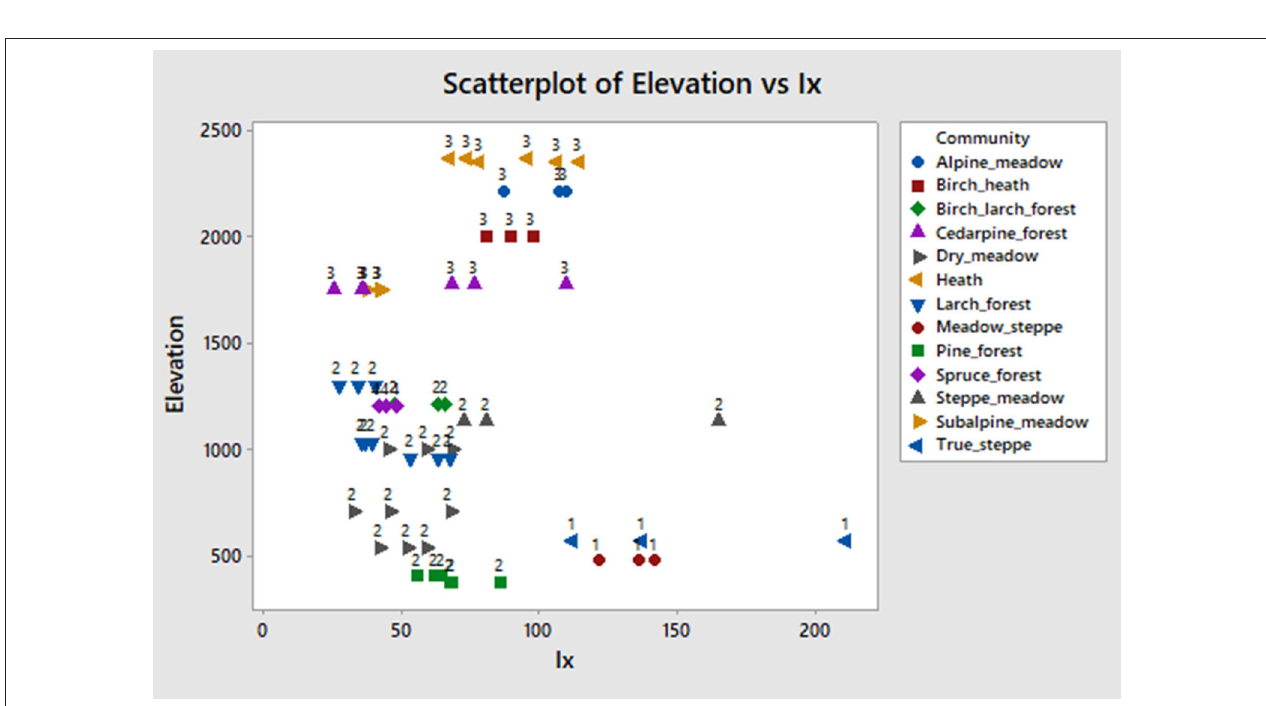
FIGURE 9 | Elevation vs. Ix index scatterplot. The index is explained in text.